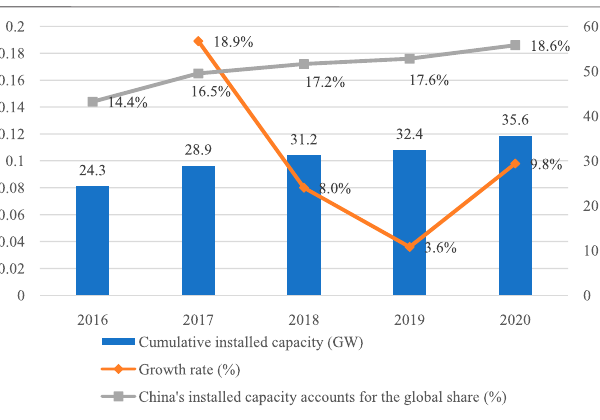
FIGURE 3 | Cumulative installed capacity and growth rate of the global EES in 2014 – 2020 (source: CNESA). FIGURE4| CumulativeinstalledcapacityoftheenergystorageforChina